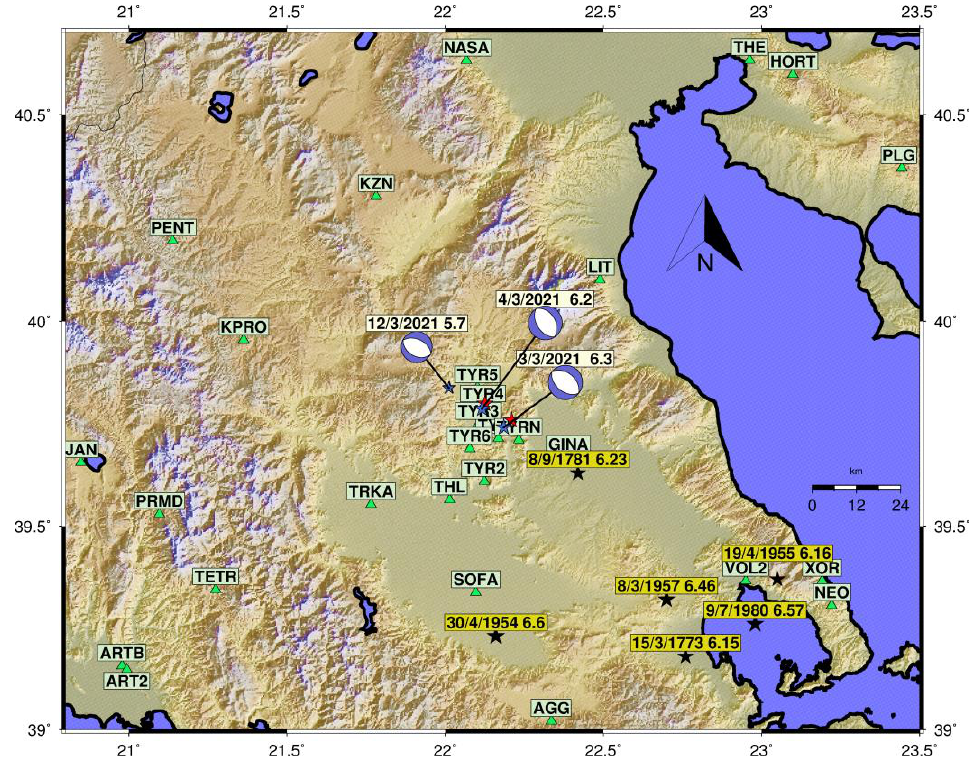
Figure 2. Epicenters (black stars), dates and magnitudes of strong historical earthquakes that occurred in Thessaly province and are mentioned in the text. Epicenters of the strong earthquakes of the 3, 4 and 12 March 2021 are shown by red (NOA’s epicenters) and blue (relocated by epicenters) stars. NOA’s epicenter of the third earthquake is not shown since it is nearly identical with the relocated one. Positions (green triangles) and code names of the stations used for relocation are also plotted. Beach-balls show the fault-plane solutions of the three 2021 earthquakes produced by the GEOFON/GFZ system.